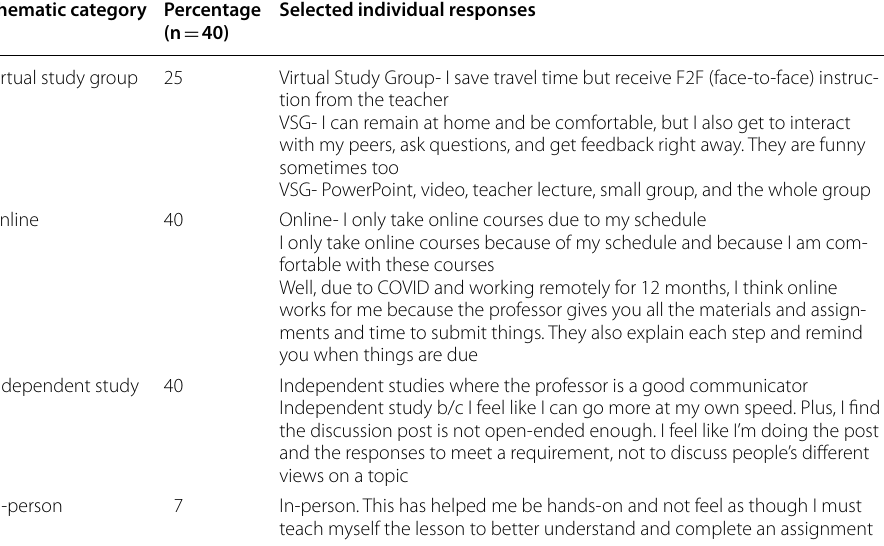
Table 9 Thematic coding of open-ended question 1 Thematic category Percentage (n =